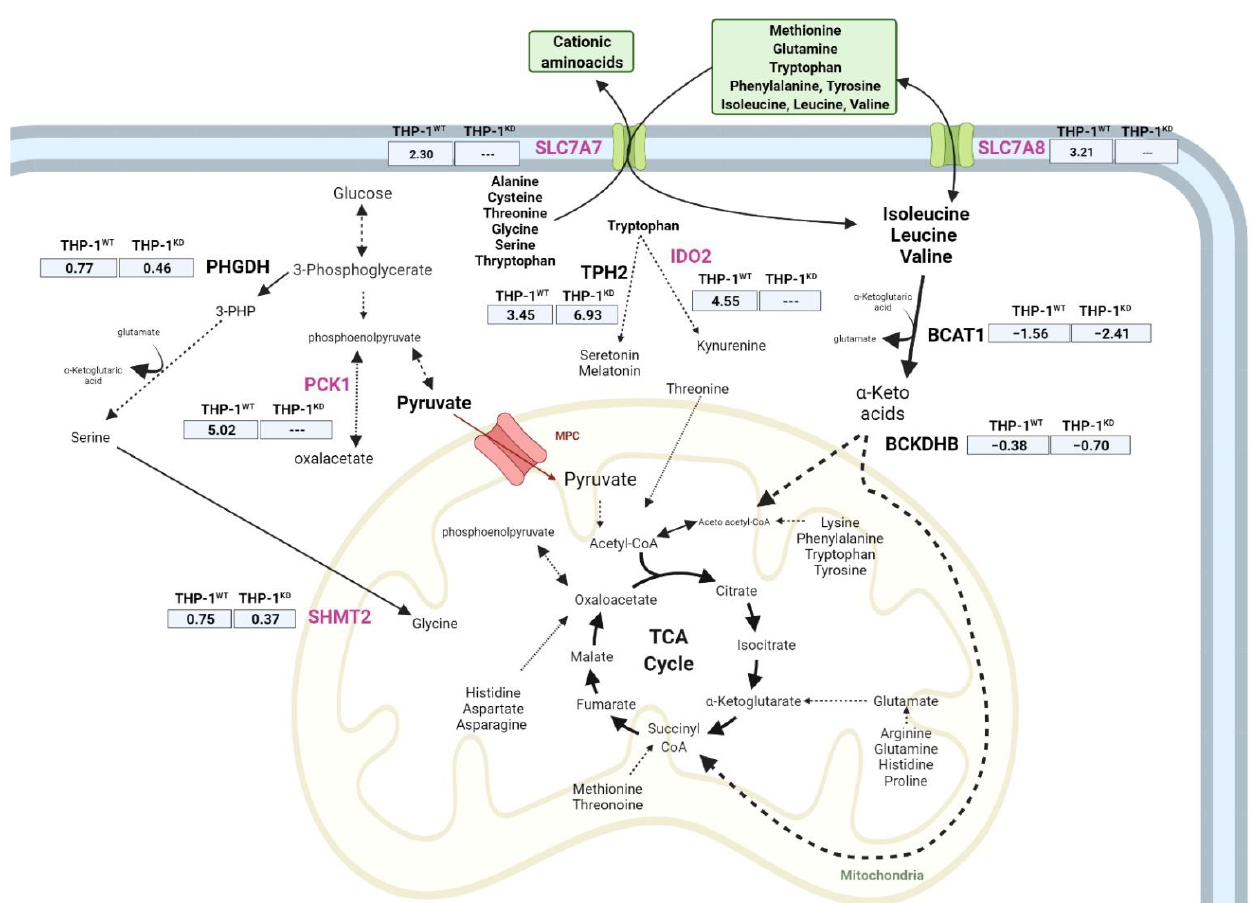
Figure 7. Gene expression changes in amino acid transport and catabolism between THP-1 WT and THP-1 KD in hypoxia. Significant changing genes due to TKTL1 highlighted in pink. Expression changes in normoxia versus hypoxia, indicated in log2-fold-change of n = 3 samples per condition.